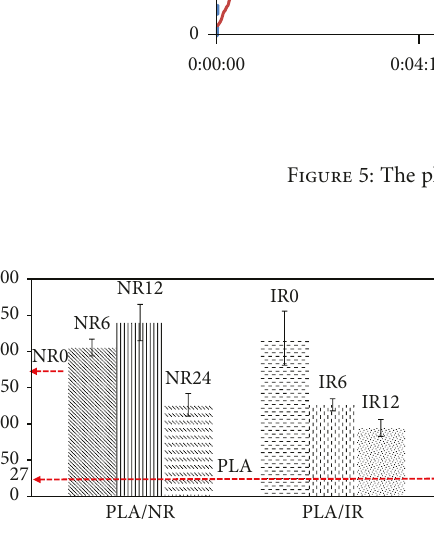
Figure 6: The impact strength of PLA/rubber blends.